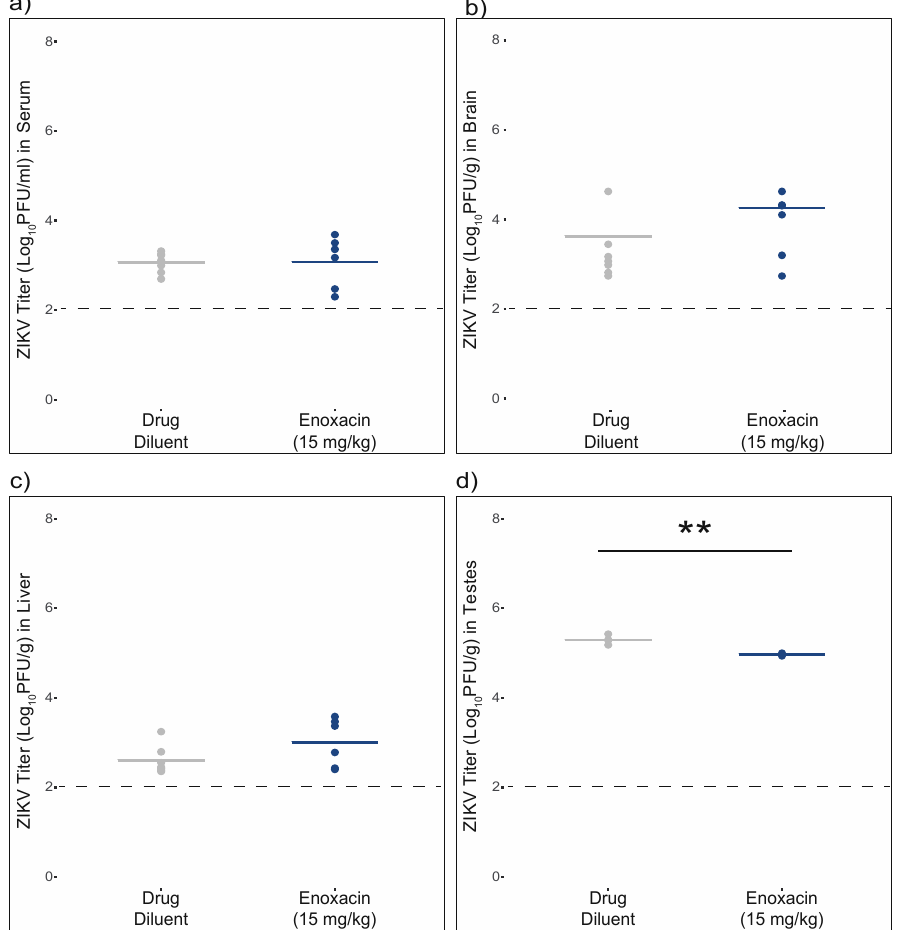
Figure 5. Treatment with enoxacin prior to and following low-titer ZIKV infection suppresses viral replication in the testes but not in serum, brain or liver. Individual (dots) and mean (line) ZIKV titers of mice treated with the drug diluent or enoxacin from ( a ) sera, ( b ) brain, ( c ) liver, and ( d ) testes. Sample sizes for each treatment are listed in Table 2 and statistical analysis is described in the text. ** p < 0.005.